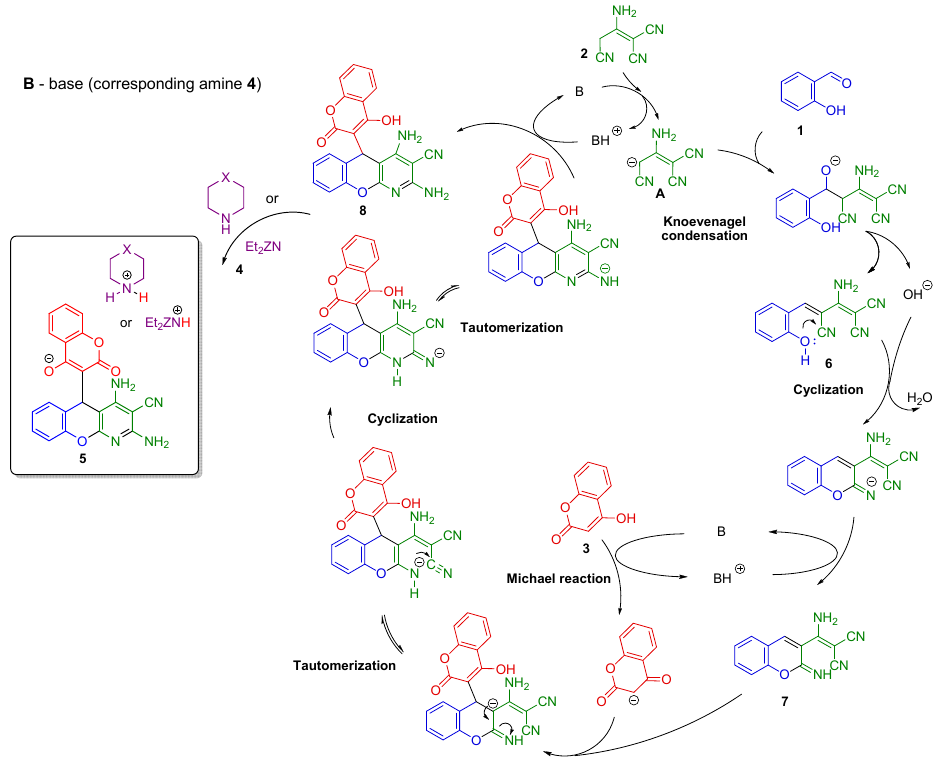
Scheme 3. Proposed mechanism of salicylaldehydes 1 , malononitrile dimer 2 , 4-Hydroxy-2 H -chromen-2-one 3 and amines 4 transformation into ammonium salt of chromeno[2,3- b ]pyridines 5